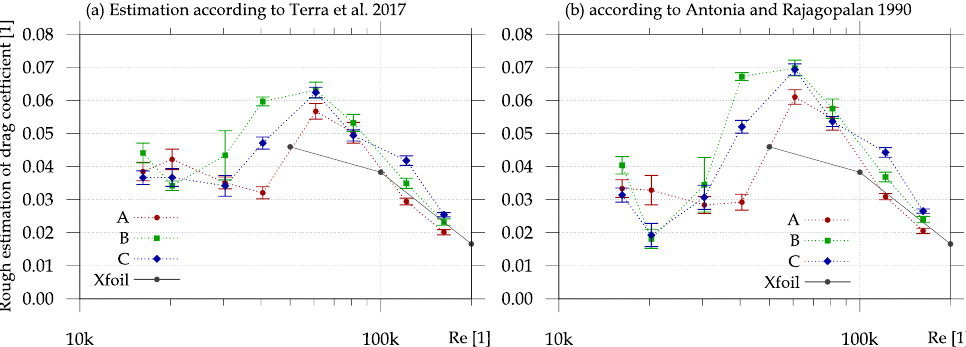
Figure 20. Rough estimation of the drag coefficient based only on the momentum deficit and stress term; the pressure term is ignored. Panel ( a ) is processed via the methodology of Terra et al. [28], while panel ( b ) shows the drag coefficient estimated according to Antonia and Rajagopalan [32] based on the same PIV data. Black points denote data obtained from the public database Airfoiltools [3] calculated by using the Xfoil [5,26,27] for the N crit = 9. Angle of attack α = 0 ◦ in both